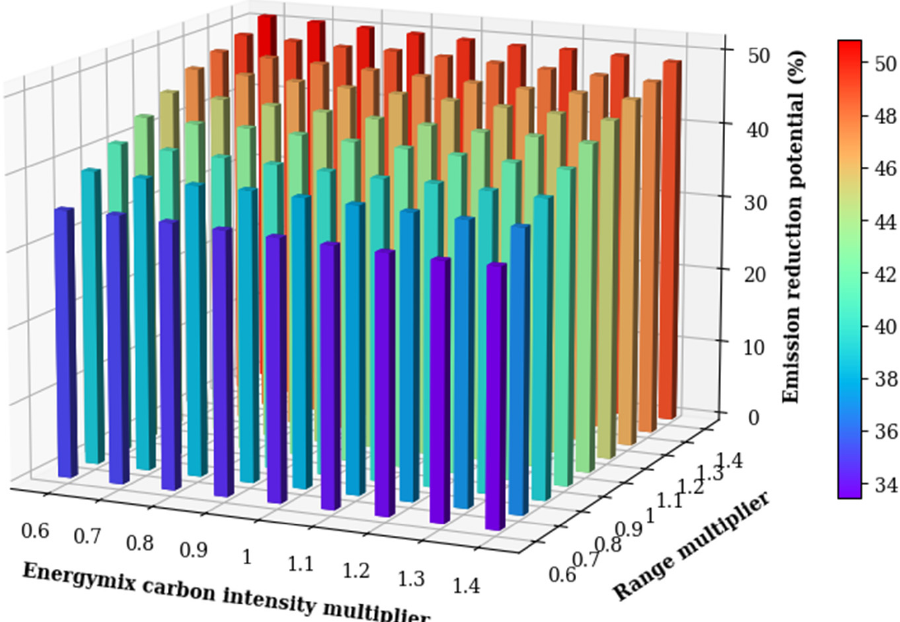
Figure 6. Sensitivity of the results to the carbon intensity of the energy mix (varies from 138 to 322 g CO 2eq per kWh) and to the relevant travel distance (varies from 0.6 to 1.4 times the baseline values for each LEV in Table 2).